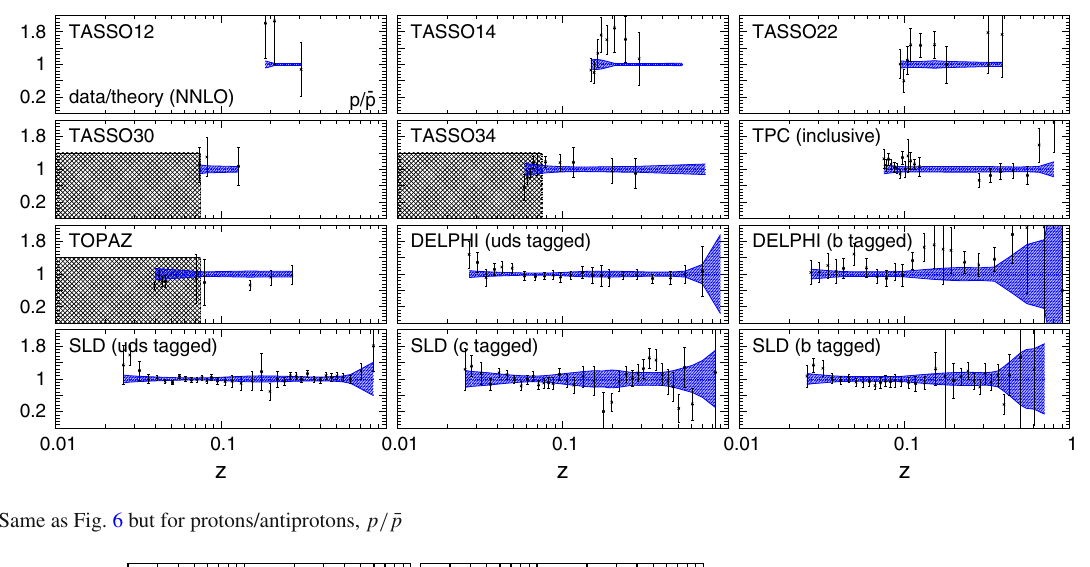
Fig. 8 Same as Fig. 6 but for protons/antiprotons, p / ¯ p